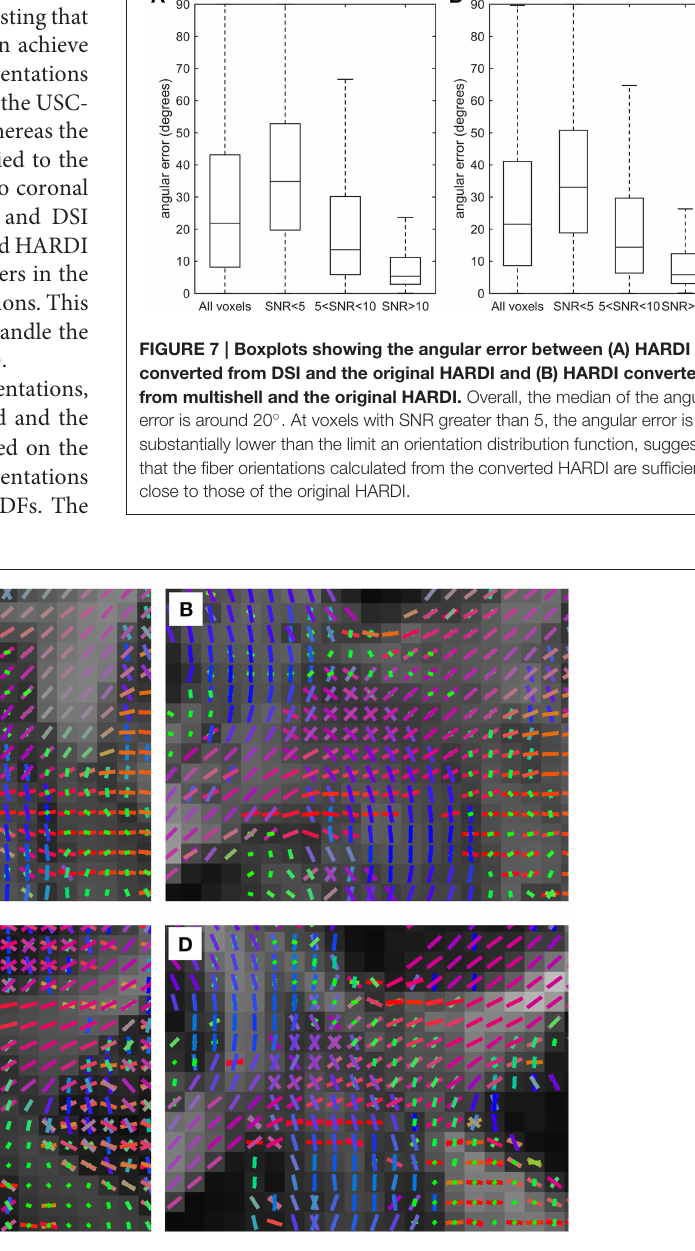
Frontiers in Neuroscience |